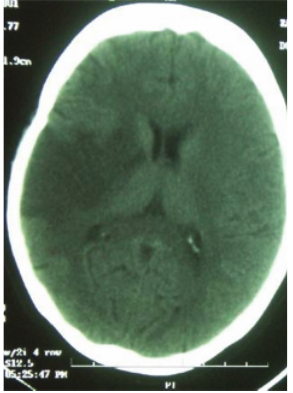
Figure 1: Plain CT scan brain showing a massive right MCA territory infarct during